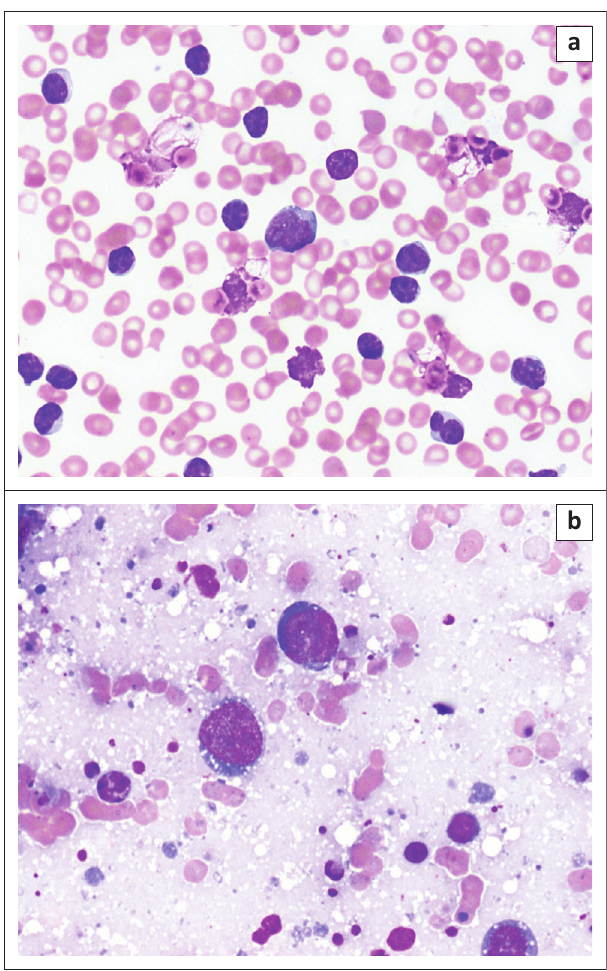
FIGURE 2: Haematoxylin and eosin (H&E) stain of a section of the bone marrow biopsy demonstrating sheets of pleomorphic cells with prominent nucleoli and